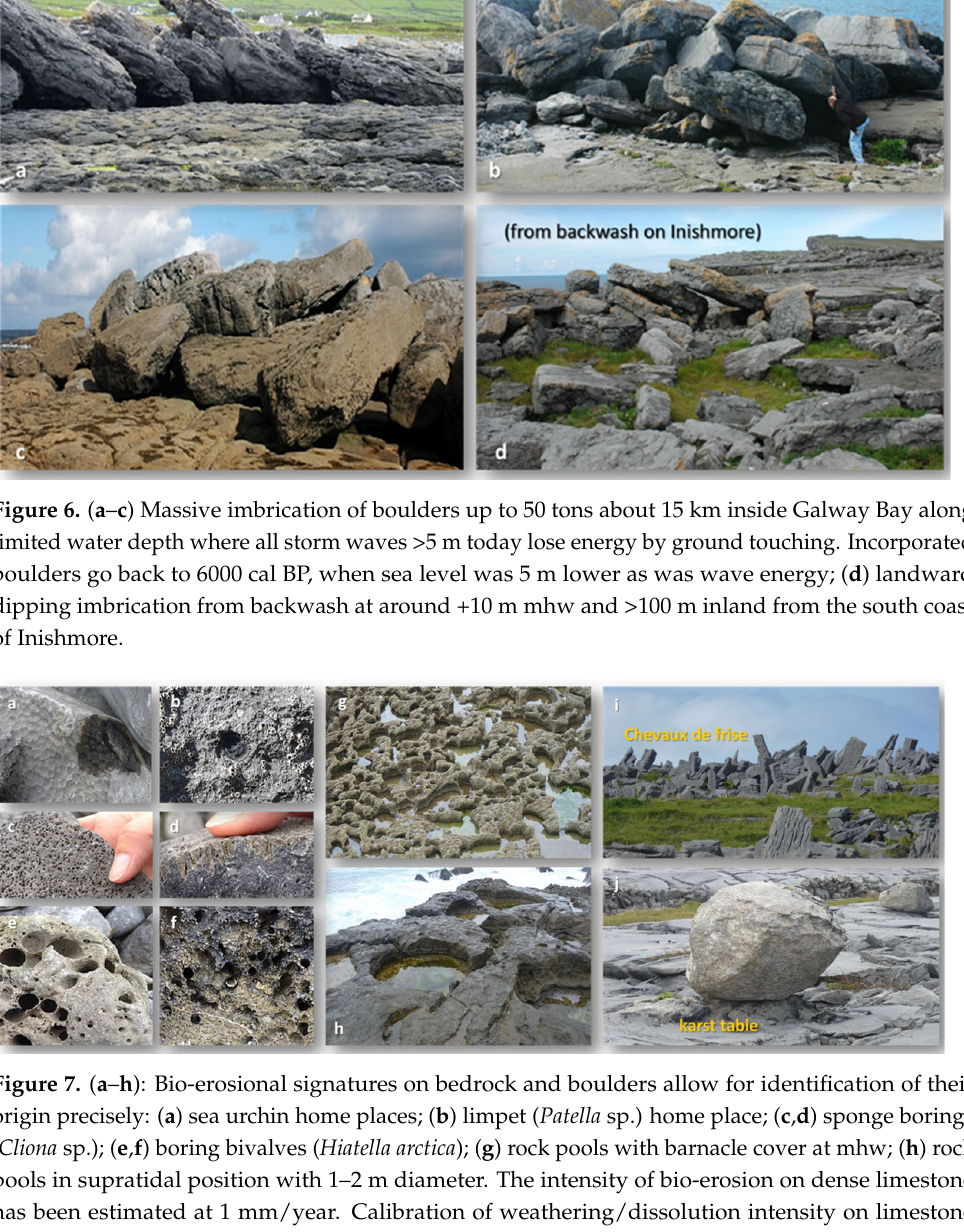
Figure 5. Relation of boulder forms to transport energy: ( a , b ) lifting and overturning from hurricane waves 2004 on Bonaire (southern Caribbean); ( c ) imbrication train from partly overturned boulders (axes up to 9 m) at +10 m during the 1755 CE Lisbon Tsunami in Morocco; ( d , e ) platy boulders of 50+ tons at +9–11 m mhw and up to 200 m from the coastline at the SE coast of Inishmaan.